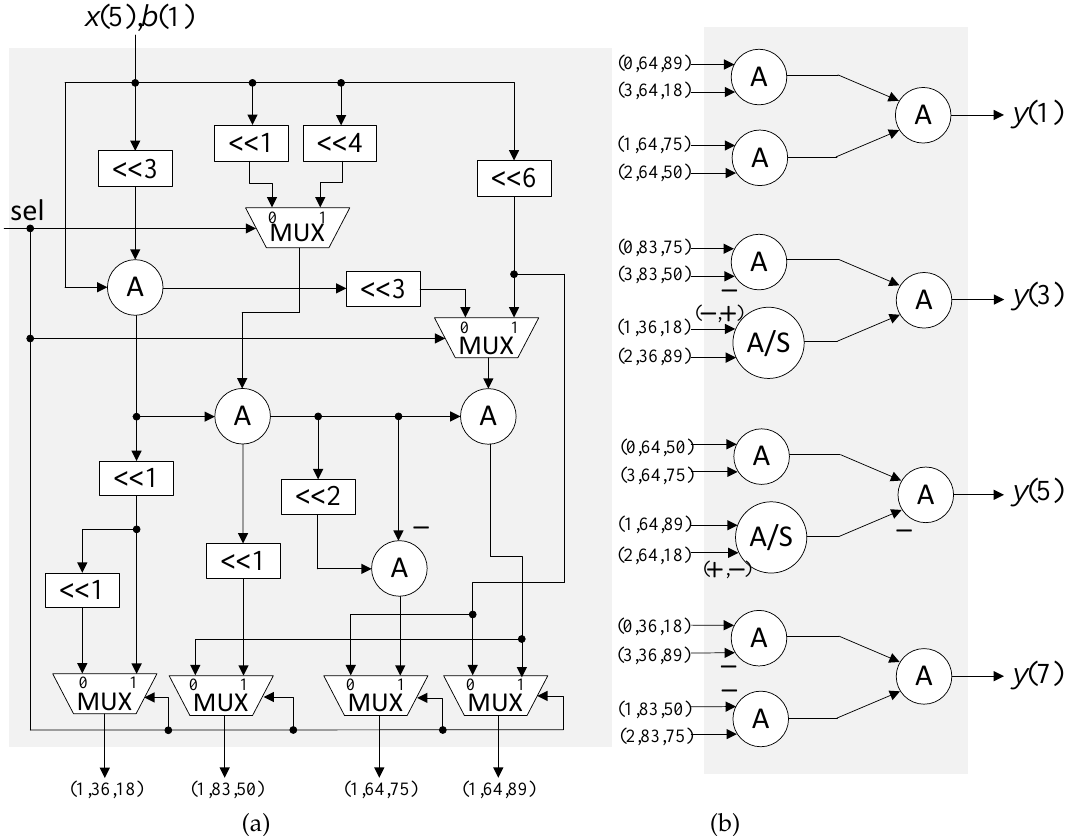
Figure 4. ( a ) Configurable Shift-Add Unit (CSAU)-1 for the eight-point DCT structure. ( b ) The OAU for the eight-point DCT structure. Input of the OAU ( a , b , c ) means the output of CSAU- a where b and c are used for the four- or eight-point DCT computations according to sel ,